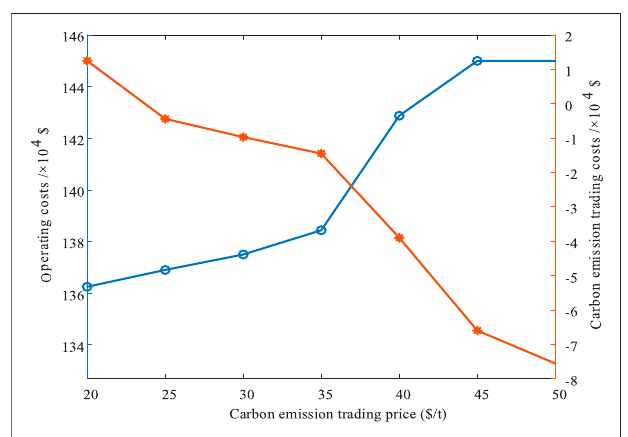
FIGURE 7 | Operating costs and carbon emission trading costs of IEMSP under different carbon emission trading prices.